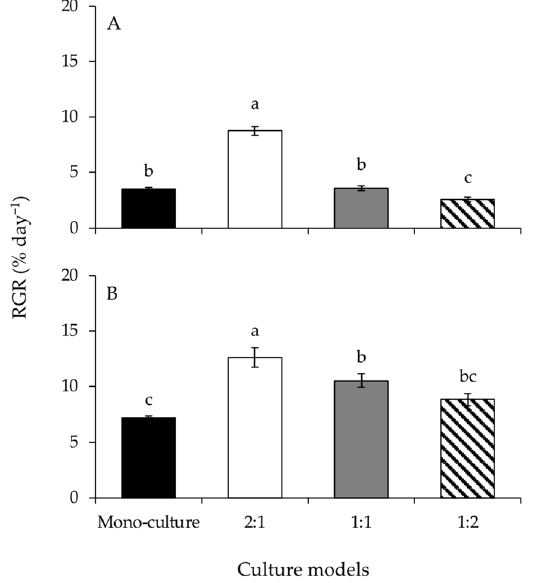
Figure 1. The RGRs of Gracilariopsis lemaneiformis ( A ) and Sargassum horneri ( B ) cultured for twelve days at mono-culture and co-culture with biomass density ratios of 2:1, 1:1, and 1:2. Different lowercase letters represent significant differences ( p < 0.05) among culture models. Table 1. One-way ANOVA testing of the effects of biomass density ratio on RGR, net photosynthetic rate, NO 3 -N uptake rate, Chl a , soluble protein, and carbohydrate of Gracilariopsis lemaneiformis and Sargassum horneri .